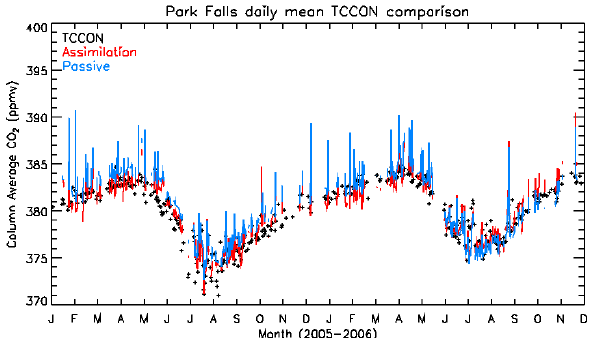
Fig. 15. Daily averaged total column CO 2 over Park Falls, Wiscon- Figure 15: Daily averaged total column CO 2 over Park Falls, Wisconsin for the period January to sin for the period January to December 2006 for observations from December 2006 for observations from TCCON (black), model (blue) and assimilation (red). The